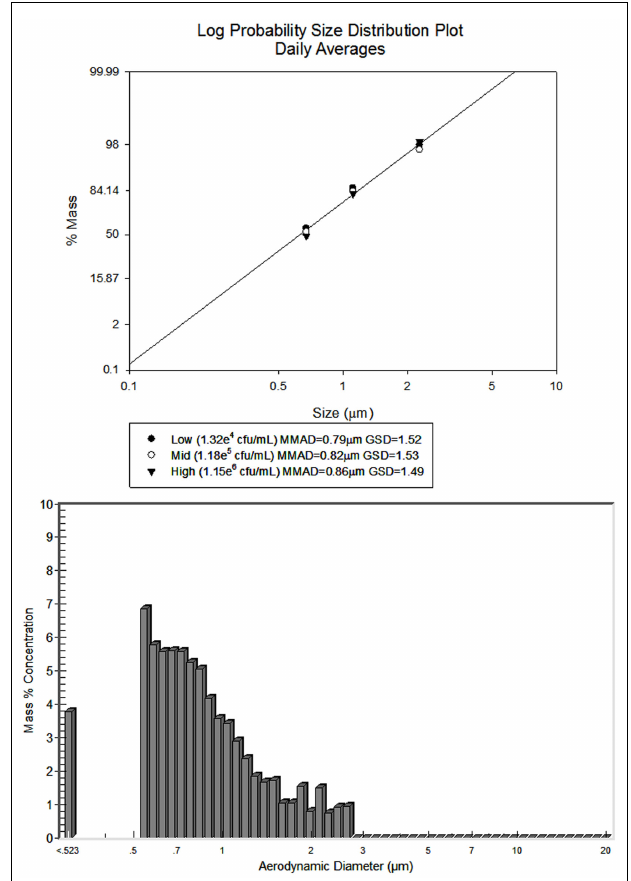
FIGURE 4 | Log distribution plot of the MMAD and GSD for the multiple exposure day study along with a representative particle distribution graph from theAPS for the low-dose